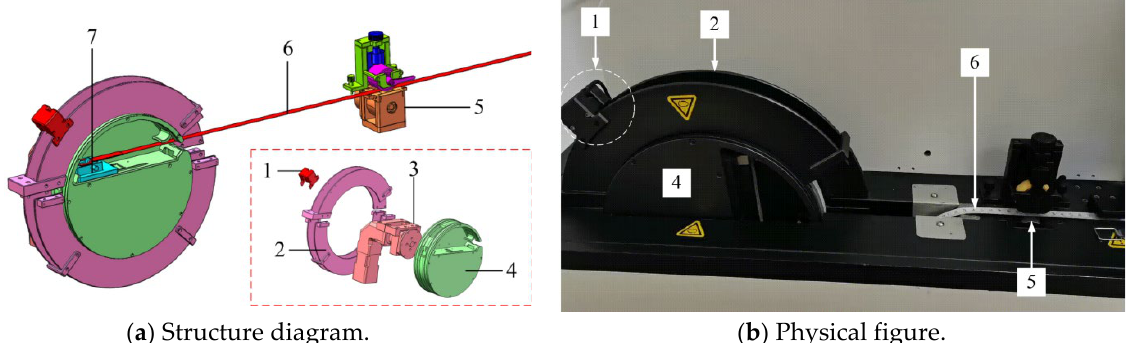
Figure 3. Tape-winding mechanism: 1. Reflective photoelectric sensor; 2. fixed parts; 3. drive motor; 4. rotary table; 5. tape belt positioning mechanism; 6. steel tape; 7. zero-installation fixture.